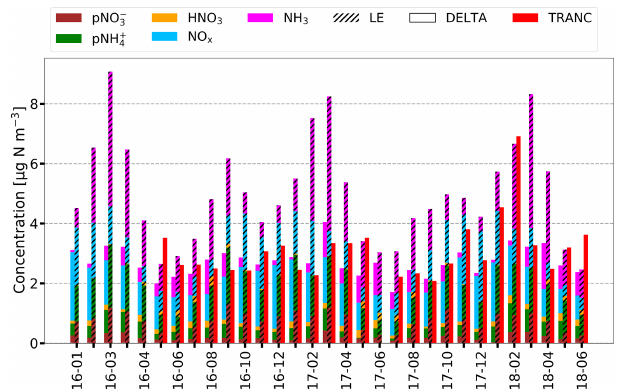
Figure 2. Monthly stacked concentration of LOTOS-EUROS (LE) (hatched), TRANC (red), DELTA, and NO x in µgNm − 3 for the en- tire measurement campaign. Gaps in the NH 3 time series caused by a low pump flow of the denuder pump were filled with passive sam- pler values from 30m. This procedure was done for December 2016 and 2017, March 2018, and April 2018. Remaining gaps in the time series of HNO 3 , p NH + , and p NO − were replaced by monthly aver- 4 3 ages estimated from other years, if available. In the case of NH 3 , the procedure was applied to January 2017. For the other compounds, the gap filling was done for December 2017, March 2018, and April 2018. Results from LOTOS-EUROS, TRANC, and NO x measure- ments were averaged to the exposure periods of the DELTA sam-